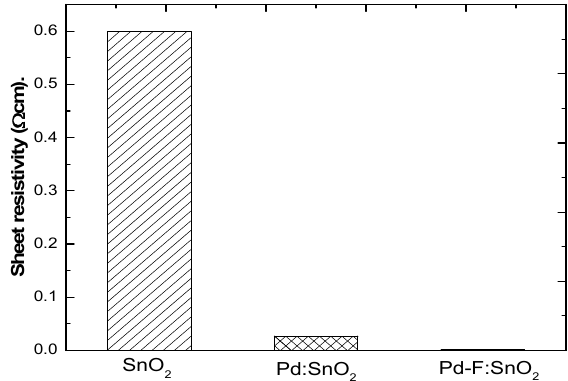
Figure 6. Sheet resistivity characteristics of SnO 2 , Pd:SnO 2 and Pd-F:SnO 2 thin